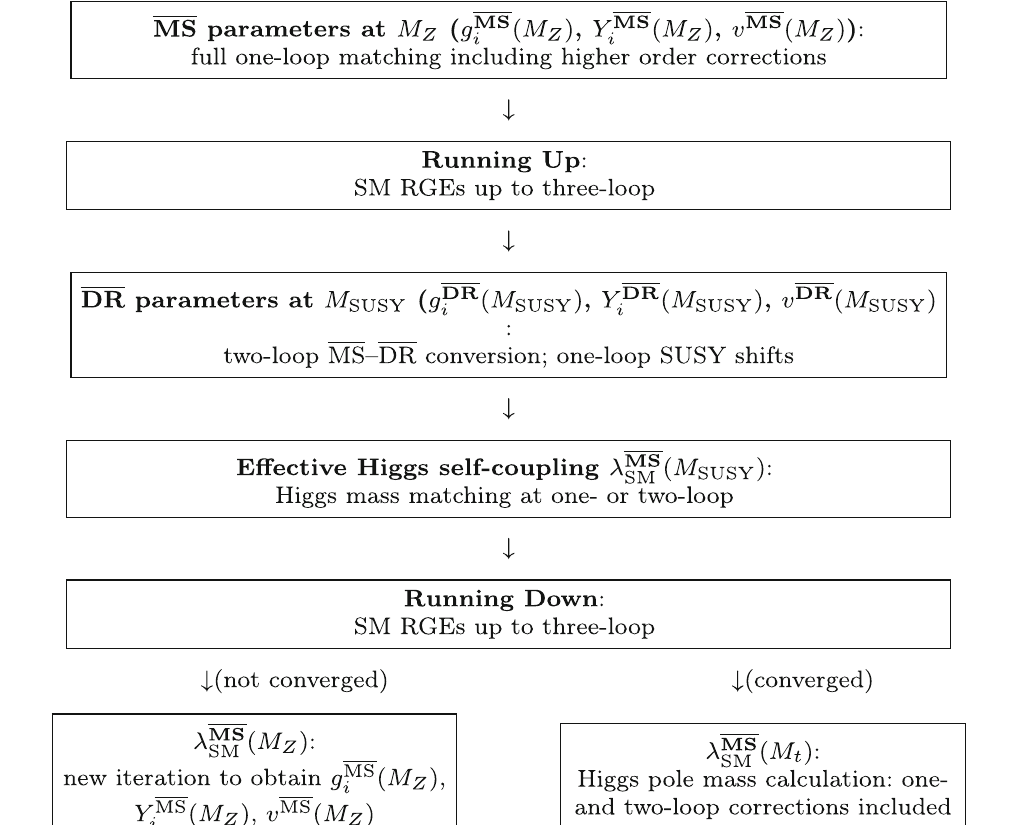
Fig. 1 Schematic procedure of the two-scale matching